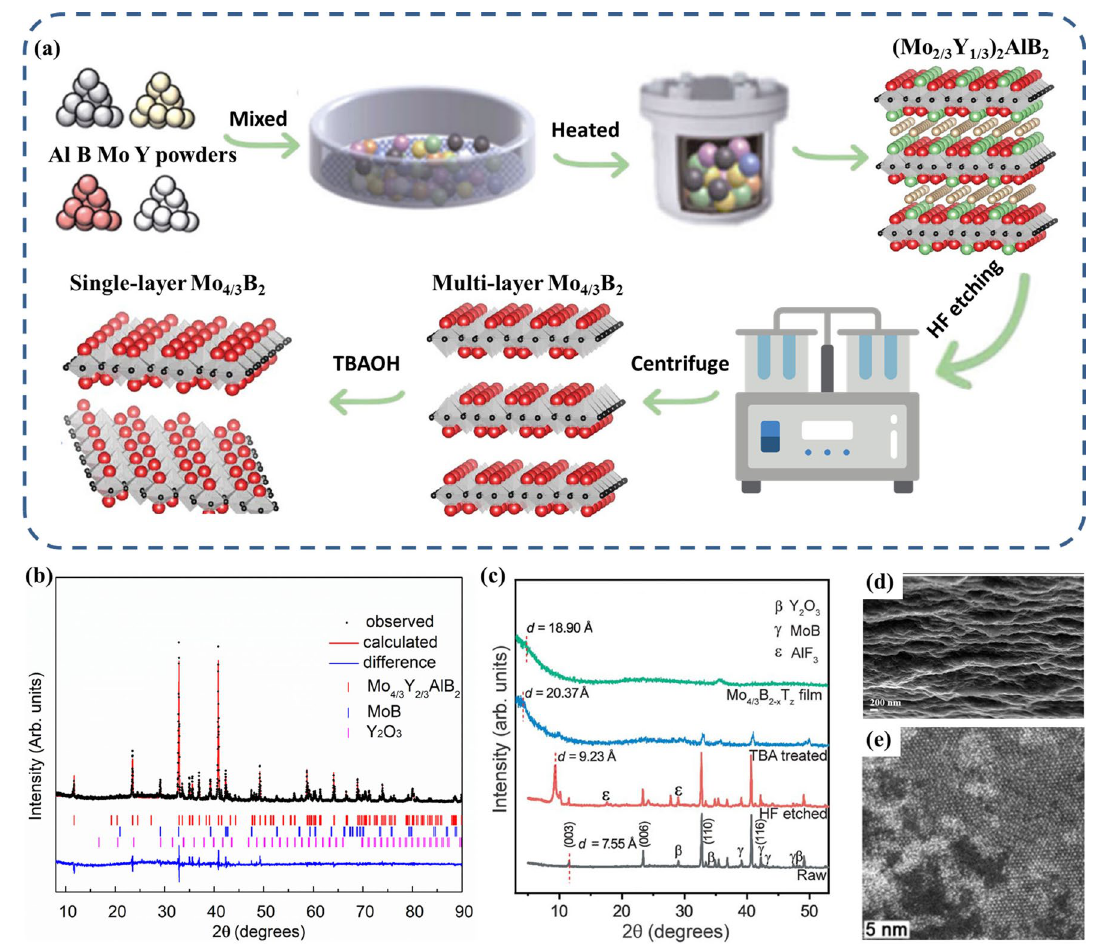
Fig. 6 a Schematic of the synthesis of 3D (Mo 2/3 Y 1/3 ) 2 AlB 2 and transformation process from i-MAB to 2D boridene with the schematic atomic structure. b Rietveld refinement of the sample with nominal composition of (Mo 2/3 Y 1/3 ) 2 AlB 2 . c XRD pattern of (Mo 2/3 Y 1/3 ) 2 AlB 2 before (black) and after (red) HF and after TBAOH intercalation (blue) and delamination (green). d SEM image showing the cross section of a Mo 4/3 B 2-x T z film. e STEM image of single-layer Mo 4/3 B 2-x T z sheet. Reproduced with permission from Ref. [83]. (Color figure